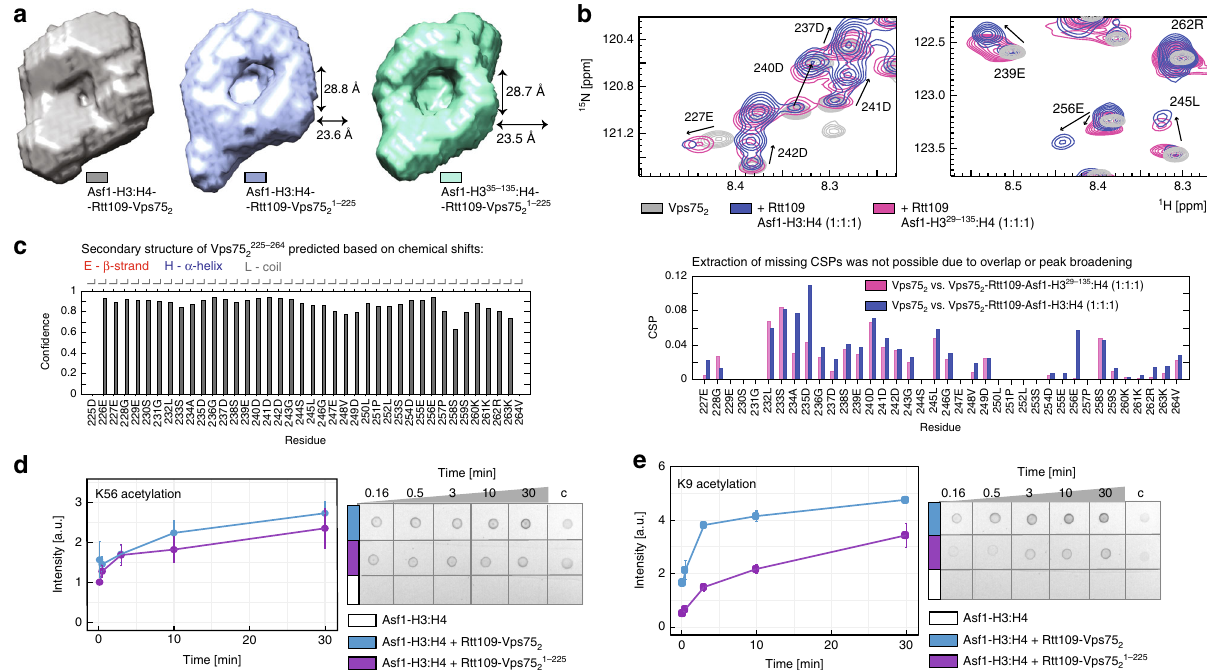
Fig. 5 The disordered Vps75 CTAD guides substrate speci fi city. a The SANS-derived ab initio envelopes of Asf1 – H3:H4 – Rtt109 – Vps75 2 1 – 225 (middle) and Asf1 – H3 35 – 135 :H4 – Rtt109 – Vps75 2 1 – 225 (right) display a central empty cavity, which is fi lled by scattering units in the complex containing full-length proteins (left). Therefore the H3 tail does not enter the cavity in the absence of the Vps75 CTAD. b Overlay of 1 H- 15 N spectra of Vps75 2 in isolation and as part of either Asf1 – H3:H4 – Rtt109 – Vps75 2 or Asf1 – H3 29 – 135 :H4 – Rtt109 – Vps75 2 . Only signals of the Vps75 CTAD are visible. In Asf1 – H3: H4 – Rtt109 – Vps75 2 , the CTADs of Vps75(A) and Vps75(B) display different chemical shifts: the peaks of one of the two CTADs remain in the same positions as those from Vps75 2 , while those of the other CTAD move to new positions. The peaks of residues 234 – 246 move less far in Asf1 – H3 35 – 135 : H4 – Rtt109 – Vps75 2 (CSP plot, bottom). c TALOS-N CS analysis of Vps75 226 – 264 in the context of full-length Vps75 2 shows that the Vps75 tail is disordered. The same narrow CS dispersion is observed in the full complex (Supplementary Fig. 9). d , e Time-courses (left) of K56- ( d ) and K9-acetylation